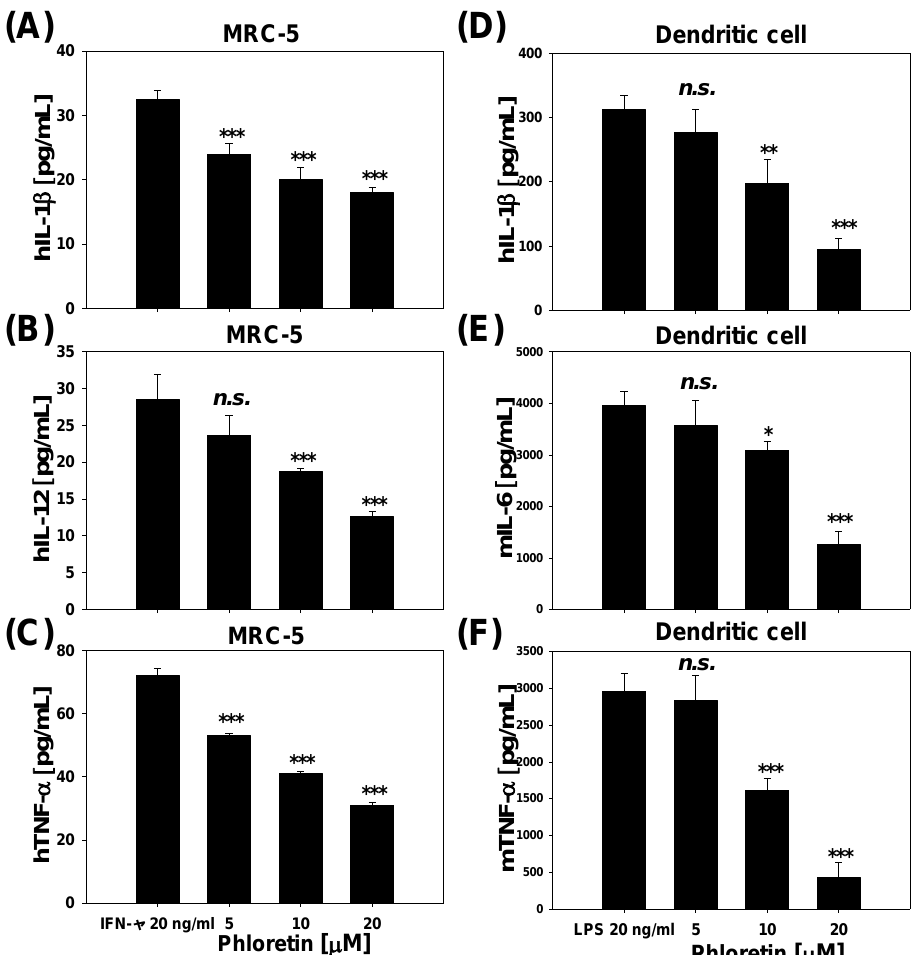
Figure 5. Levels of ( A ) interleukin (IL)-1 β ; ( B ) IL-12; and ( C ) tumor necrosis factor (TNF)- α in the culture medium of interferon (INF)- γ -stimulated MRC-5 cells; and ( D ) IL-1 β ; ( E ) IL-6; and ( F ) tumor necrosis factor (TNF)- α in the culture medium of lipopolysaccharide-stimulated dendritic cells treated with indicated concentrations of phloretin for 24 h. Data represent mean ± standard deviation of three independent experiments. * p < 0.05, ** p < 0.005, *** p < 0.001 vs. cells treated with IFN- γ only ( A – C ) or LPS only ( D – F ).